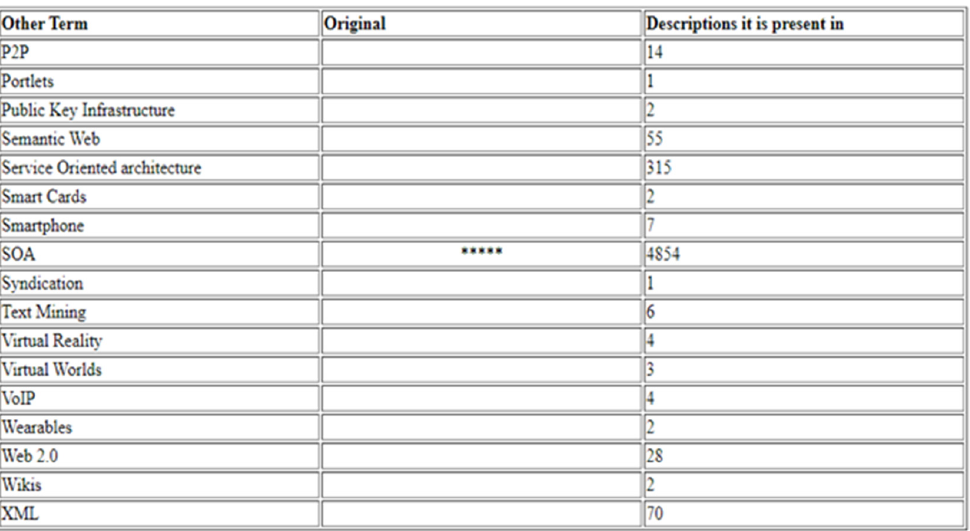
Figure 13. Detections of other topics within the SOA topic abstracts.